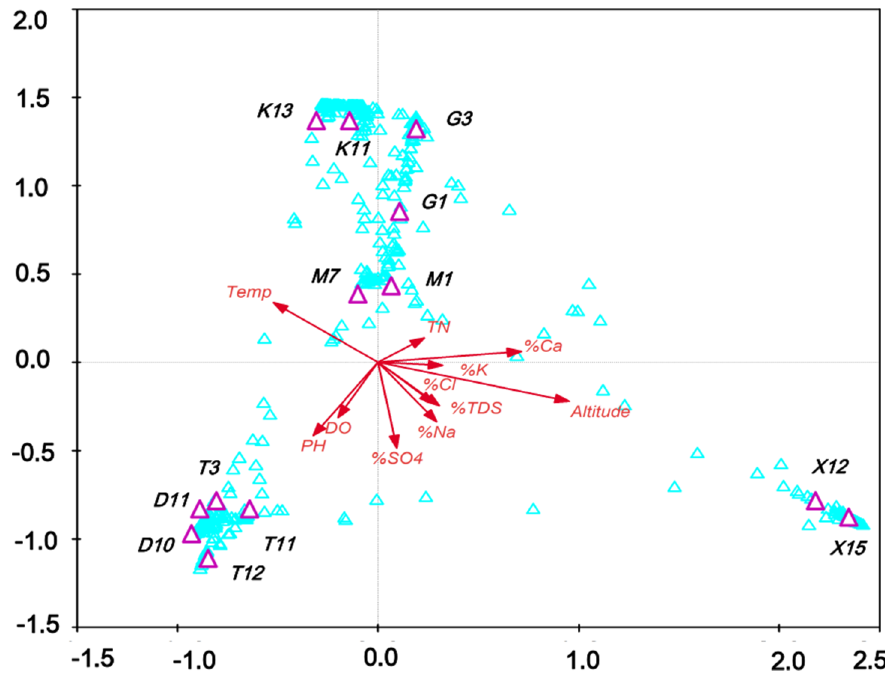
Figure 7. CCA biplots based on OTU and geographical or selected chemical parameters. Chemical parameters yield in a very similar spreading of sampling sites; DO dissolved oxygen, TN total nitrogen, TDS total dissolved solid. K, Na, Ca, Cl, SO4 was represent for ions potassium (K + ), sodium (Na + ), calcium (Ca 2 + ), chloride (Cl 2 ), and sulfate (SO 42 2 ), respectively. In Figure, K, T, D, M, X and G referred to Lake Keluke, Lake Tuosu, Lake Dasugan, Lake Gahai, Lake Xiaochaidan and Lake Gsikule, respectively.